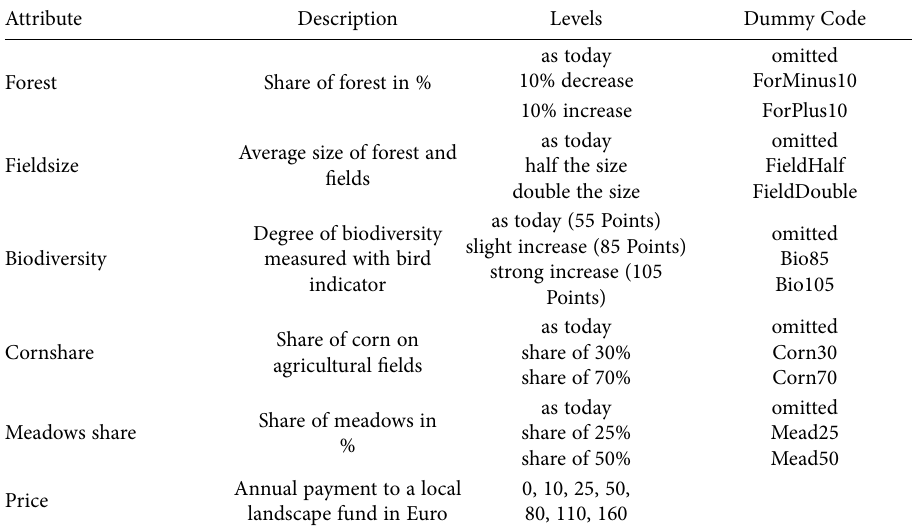
Table 1. Attribute